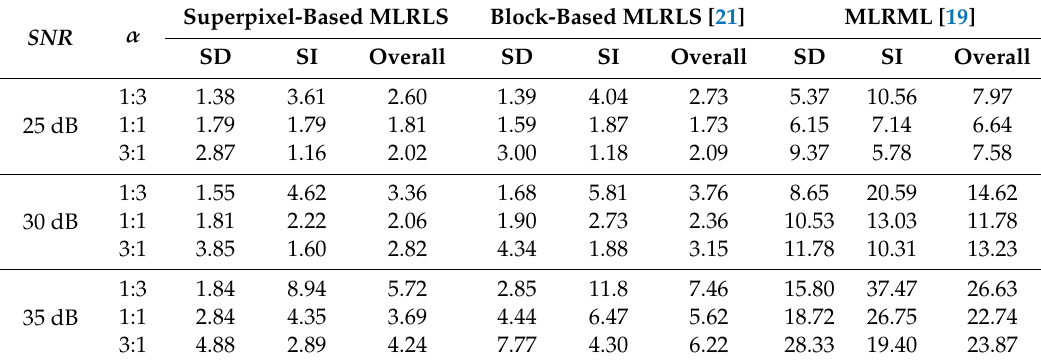
Table 1. The optimal relative errors of the SD noise, the SI noise and the overall